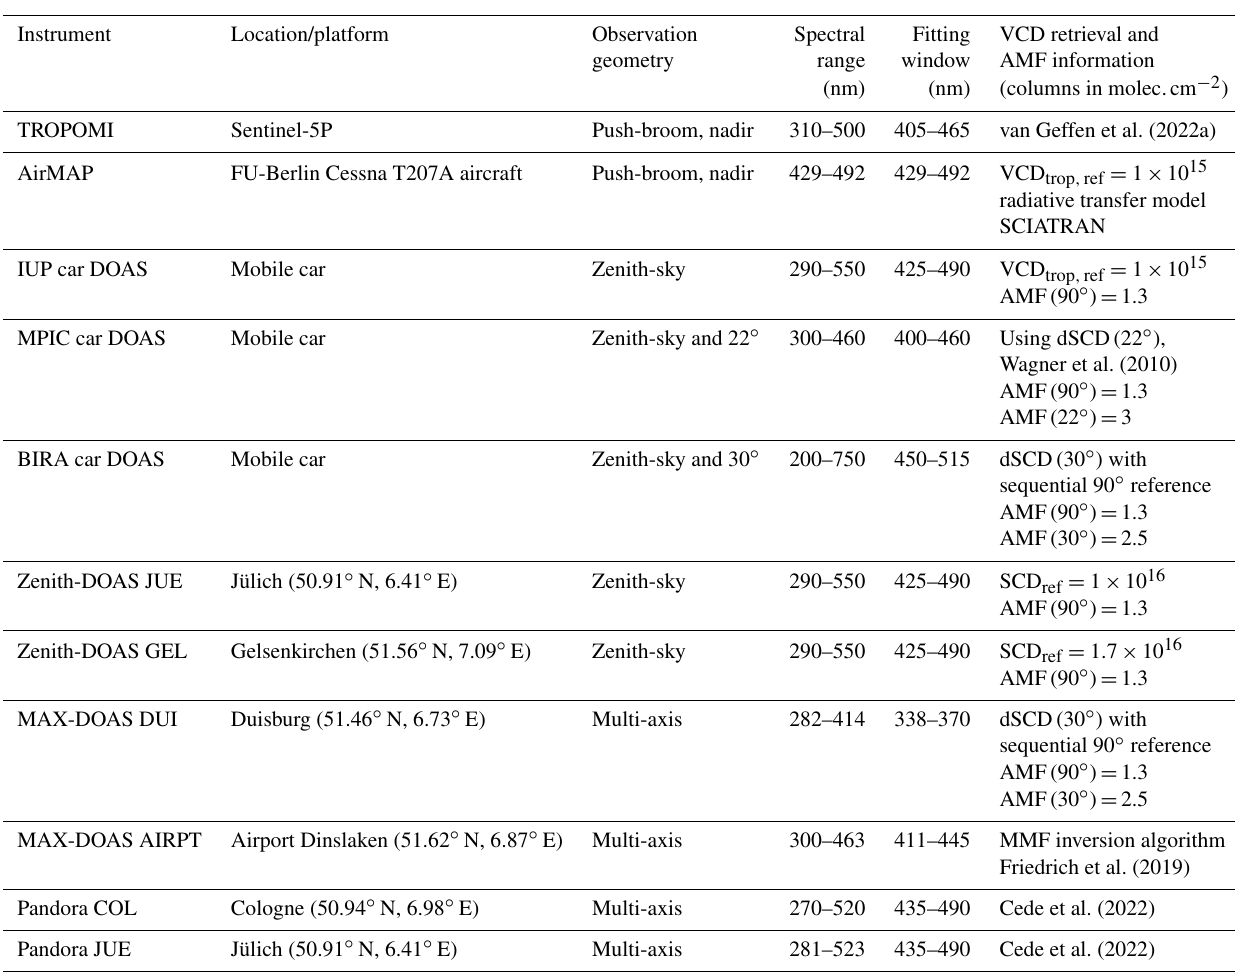
Table 2. List of instruments included in S5P-VAL-DE-Ruhr campaign activities with location and observation geometry. Car DOAS instru- ments are operated by three different institutes: the Institute of Environmental Physics, University of Bremen (IUP); the Max Planck Institute for Chemistry in Mainz (MPIC); and the Royal Belgian Institute for Space Aeronomy (BIRA).